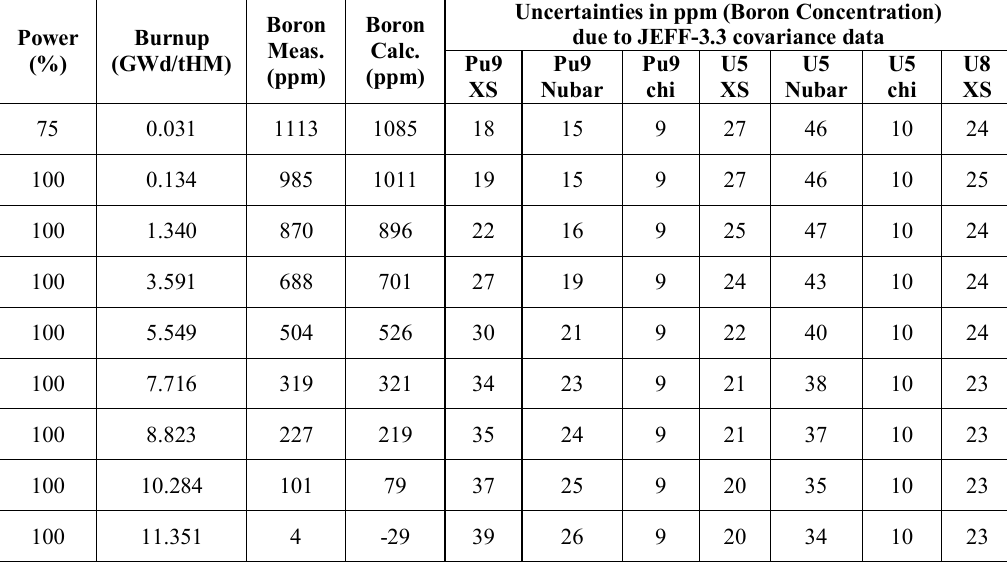
Table 1. UQ assessment for critical boron concentration in a PWR Westinghouse unit. SEANAP system is used to perform calculations. Calculation performed with a total of 2100 random files generated by SANDY tool (300 samples for each case). Measured and Calculated values are